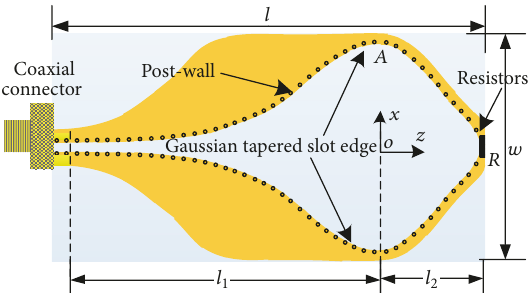
Figure 1: Configuration of proposed Gaussian tapered post-wall slotline